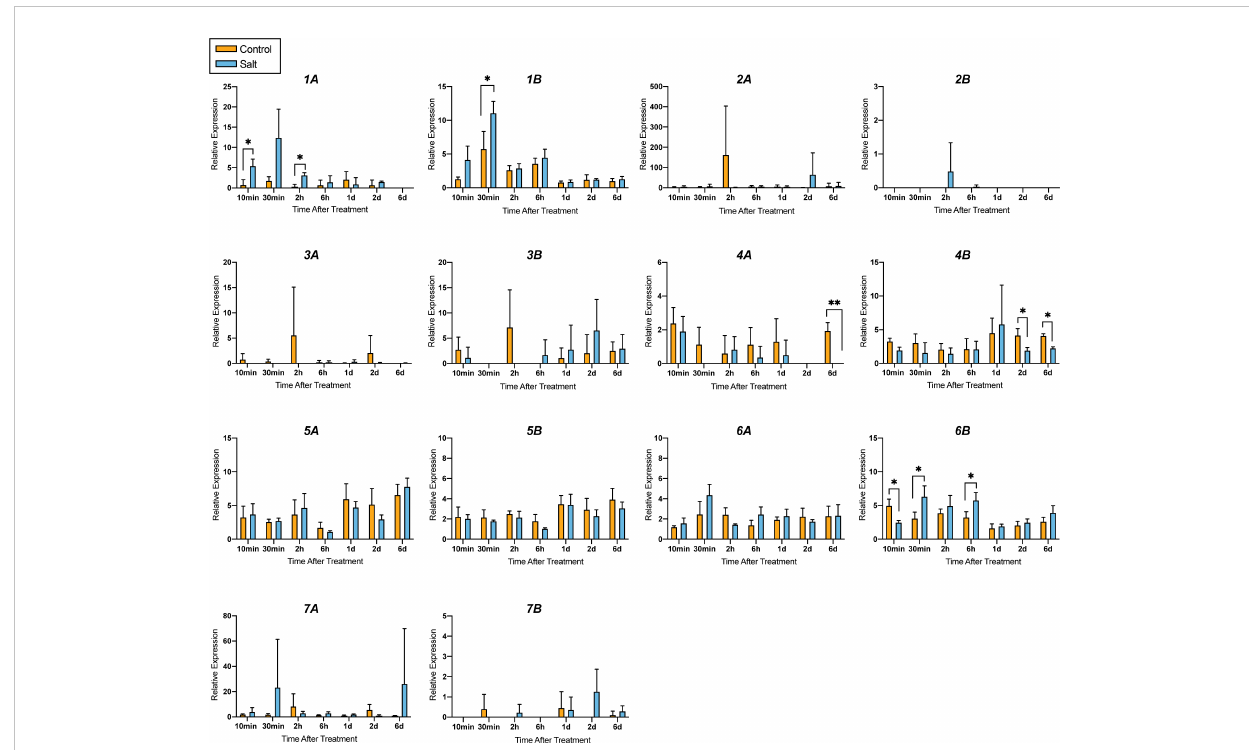
FIGURE 8 Relative expression of MdGA2ox genes in the fi rst fully expanded leaves under salt treatment. Rapidly growing ‘ Gala ’ apple seedlings were either treated with 100 ml of water (in orange) or with 100 mL of 100 mM salt (NaCl) (in blue). Gene expression was detected at 10 min, 30 min, 2 h, 6 h, 1 d, 2 d, and 6 d after treatment. Asterisks represent statistical signi fi cance (*, p < 0.05; **, p <